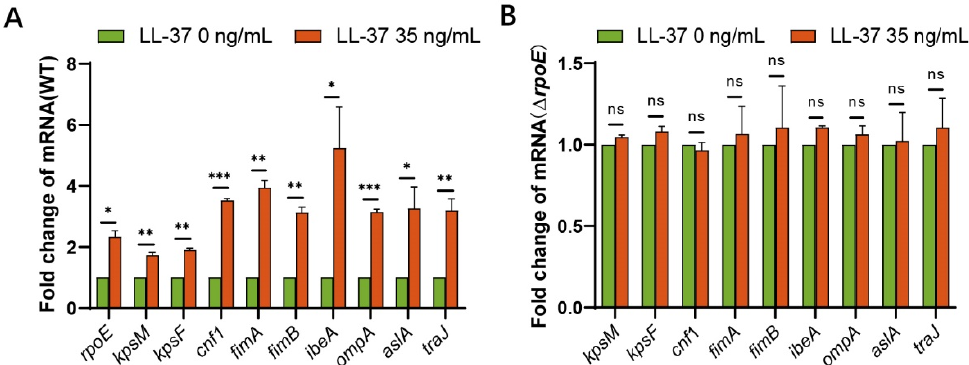
Figure 6. RpoE enhances the expression of virulence factors induced by LL-37. ( A ) Fold change in the transcriptional levels of toxic genes in the WT strain cultured with LL-37. ( B ) Fold change in the transcriptional levels of toxic genes in the ∆ rpoE mutant strain cultured with LL-37. * p < 0.05; ** p < 0.01; *** p < 0.001; ns, not significant by Student’s t -test.